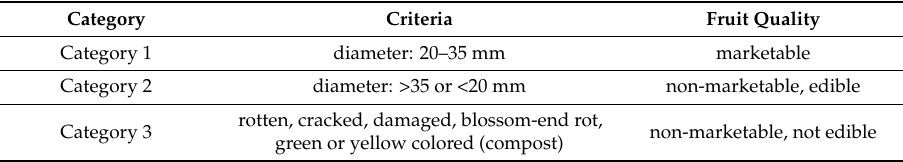
Table 2. Tomato quality classifications according to Swiss market quality norms for cherry tomatoes